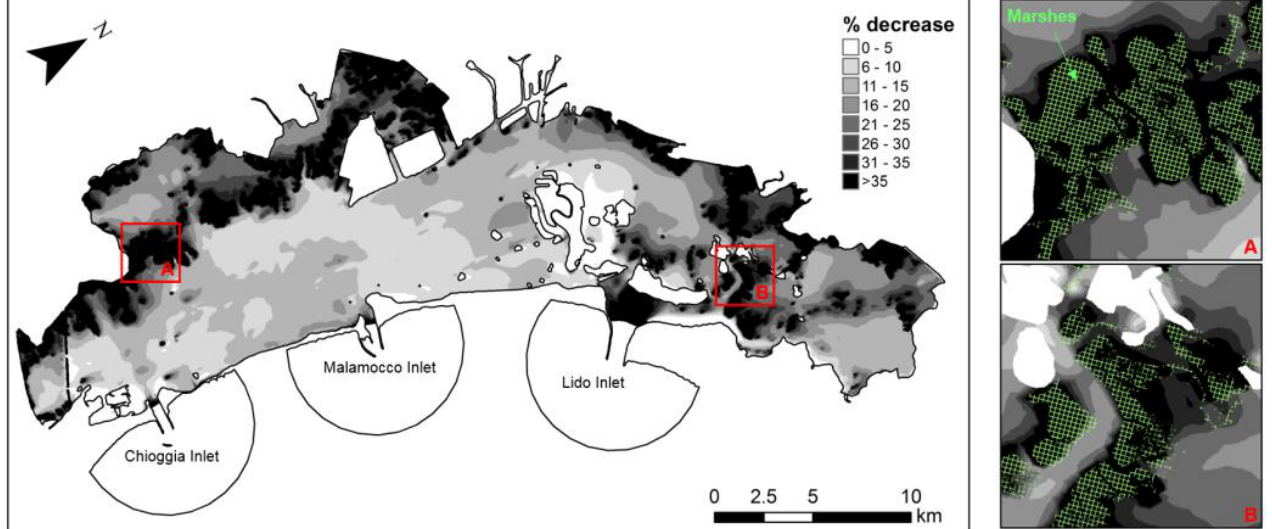
Figure 11. Average percentage decrease between the modelled Hs in the closed and open barrier scenarios. The two subfigures show zooms where marshes are present.